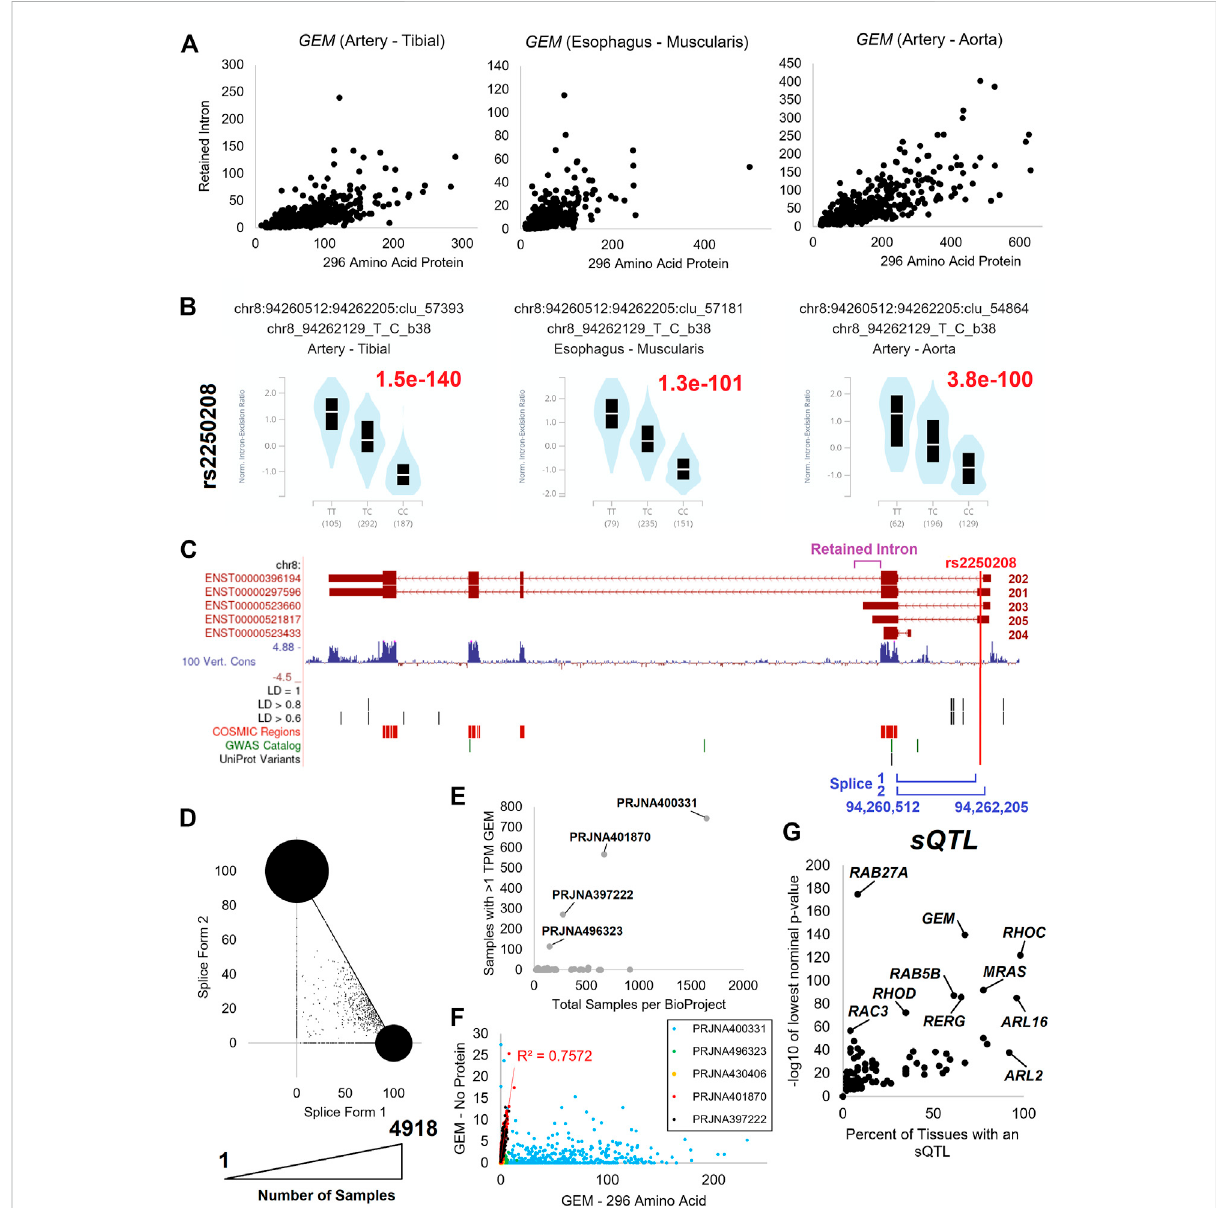
FIGURE 10 GEM isoform dynamics. (A) The expression in transcripts per million (TPM) of GEM 296 AA isoform ( x -axis) relative to retained intron transcripts ( y -axis) for tibial artery, muscularis esophagus, and aorta artery. (B) GTEx annotated splicing quantitative trait loci (sQTLs) for GEM based on rs2250208 variant for each of the three tissues in panel (A) . TT and CC are homozygous splicing levels, and TC those individuals heterozygous. The GTEx annotated p -value is labeled in red. (C) Exon map of GEN showing the location of retained intron (magenta), rs2250208 (red), and the splicing sites (blue). Labeled below the exon map are various annotated genomic features, including rs2250208-based linkage disequilibrium (LD) variants, catalog of somatic mutations (COSMIC) variants, Genome-Wide Association Study variants (GWAS), and UniProt variants. (D) Expression of the two splice forms in “ Blood PAXgene ” samples. The x -axis is the percent of transcripts using splice form 1, and the y -axis is the splice form 2. The sizeofthespotcorrespondstothenumberofsampleswithvalues. (E) CompiledanalysisoftheexpressionofGEMtranscriptsindifferentBioProjects. (F) Expression analysis of GEM protein-coding isoforms relative to retained intron transcripts for the BioProjects identi fi ed in (E) . (G) Extraction of GTEx annotated sQTLs for small GTPase genes. The x -axis shows the percent of tissues with an eQTL for the given gene, and the y -axis shows the lowest nominal p -value from GTEx analysis across those